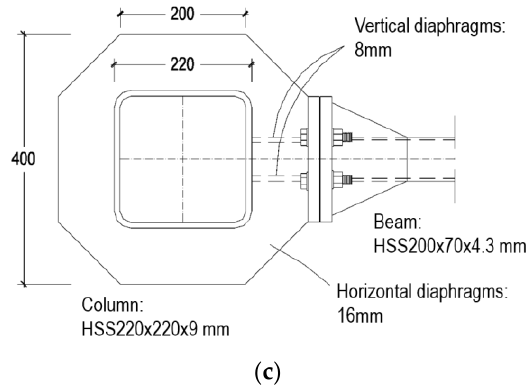
Figure 3. ( a ) Dimensions of end-plate [mm], ( b ) lateral view of the HSS moment connection [mm], ( c ) plan view of HSS moment connection [mm].